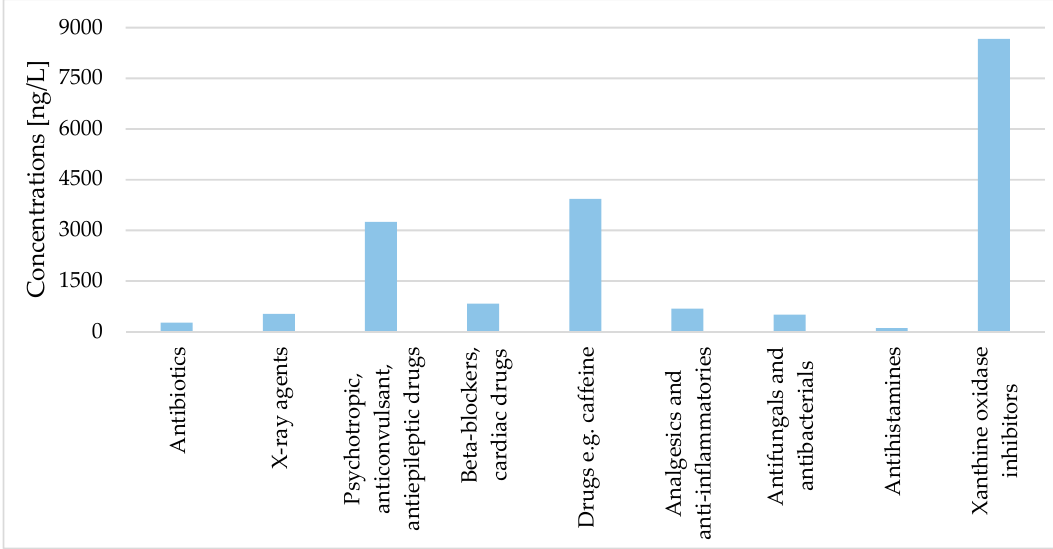
Figure 3. Sum of concentrations of all pharmaceuticals in each series in categories of pharmaceutical according to the application.